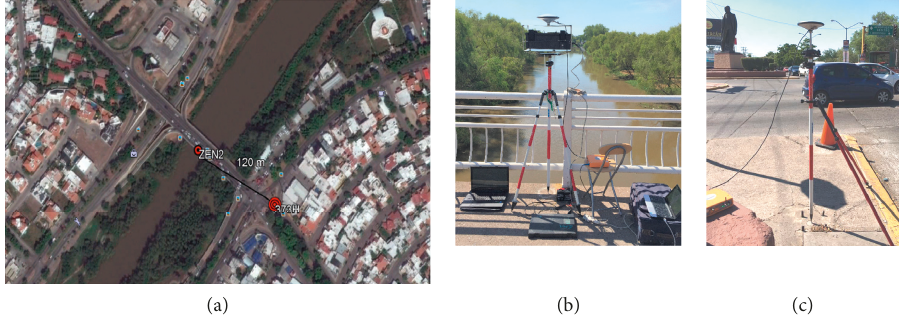
Figure 6: GPS campaign: (a) location of ZEN2 and 373H; (b) station ZEN2; (c) station